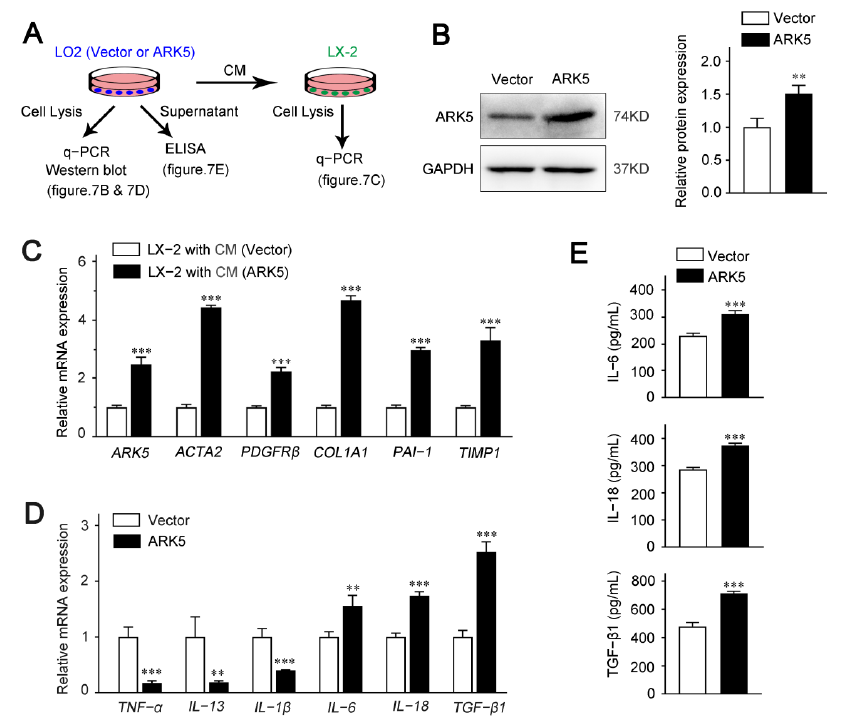
Figure 7. Up-regulation of ARK5 in hepatocytes promotes HSCs activation via crosstalk. ( A ) Schematic of experimental design showing LX-2 was cultured in medium from LO2 cells transfected with ARK5 overexpression vector and plasmid. Supernatant was collected for ELISA and cells were harvested for PCR. CM, conditioned medium. ( B ) Western blot analysis of ARK5 protein expression in LO2 cells transfected with ARK5 expression vector and plasmid. ( C ) Quantitative PCR analysis